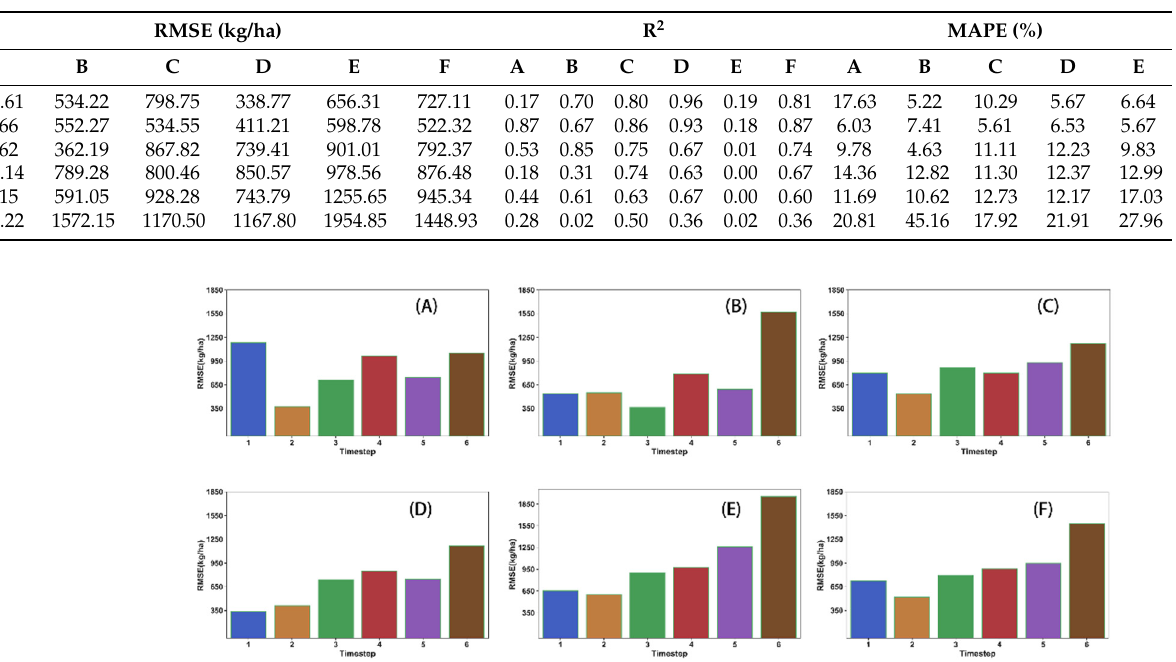
Figure 7. Comparison of the yield estimation results for LSTM models based on different time steps ( A ) one time step; ( B ) two time steps; ( C ) three time steps; ( D ) four time steps; ( E ) five time steps; and ( F ) six time steps. The probability distributions of the statistical and estimated yields are plotted on the right and top of the Y axis, respectively. Table 2. The accuracy evaluation of the LSTM prediction model was compared between different time steps when 6 LAI data were input.